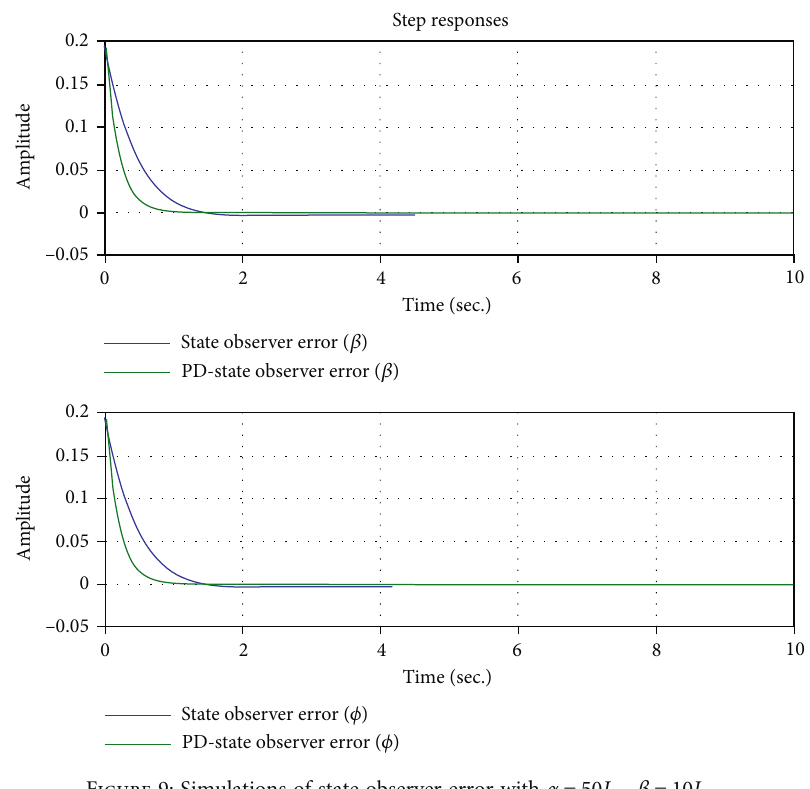
Figure 9: Simulations of state observer error with α = 50 I